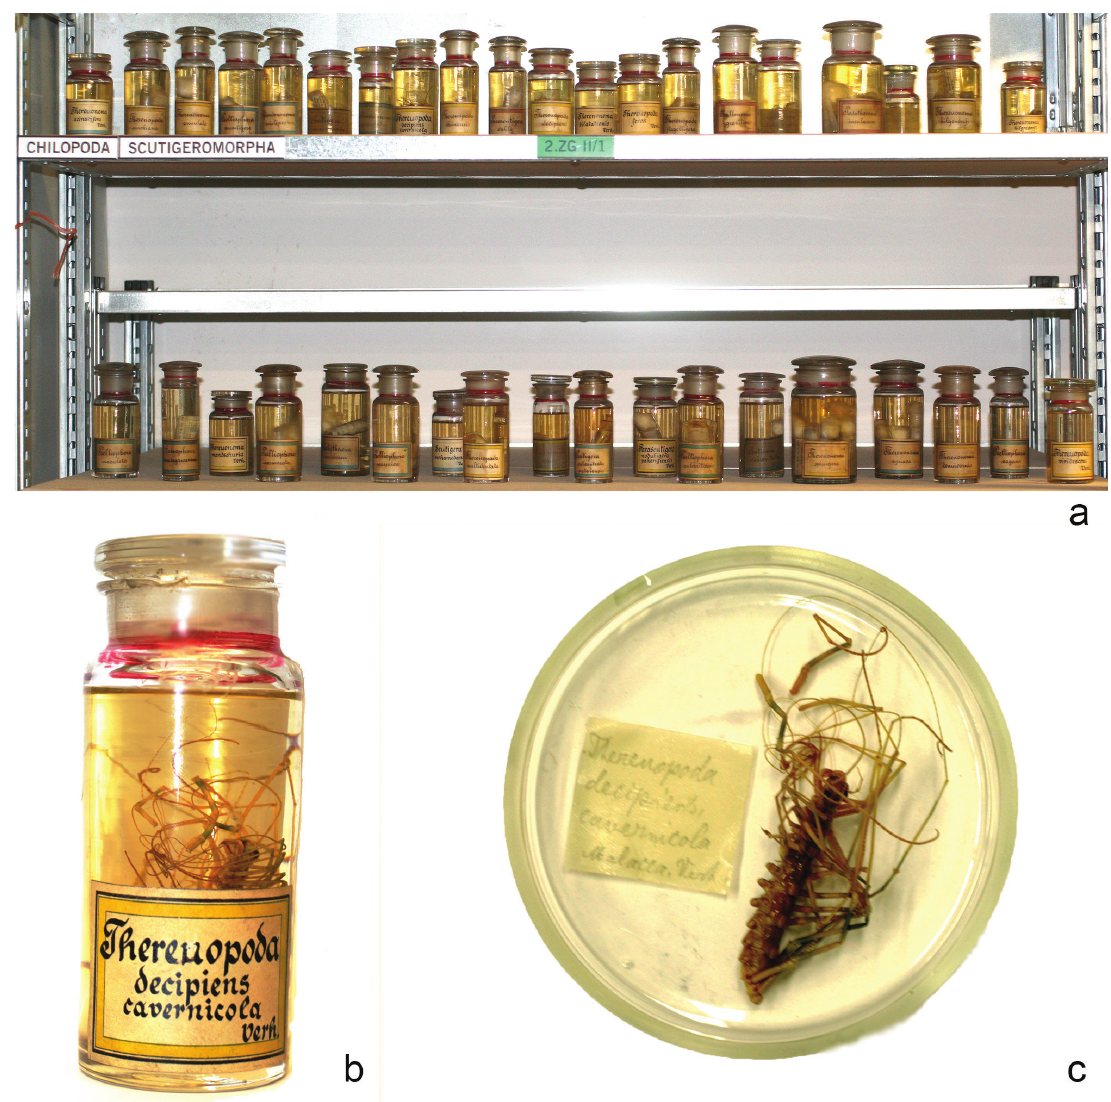
Figure 1. Alcohol material of scutigeromorph centipedes in the Museum für Naturkunde Berlin. a. Overview of the type collection on the shelves. b. Example of a jar containing type material, Theuropoda decipiens cavernicola Verhoeff, 1937 from Malaysia – a junior synonym of Thereuopoda longicornis (Fabricius, 1793) – with the historical external label and red ring indicating type mate- rial. c. A syntype of the same species, now removed from the jar, with the historical internal label. Note that some legs have become disarticulated as happens commonly with these